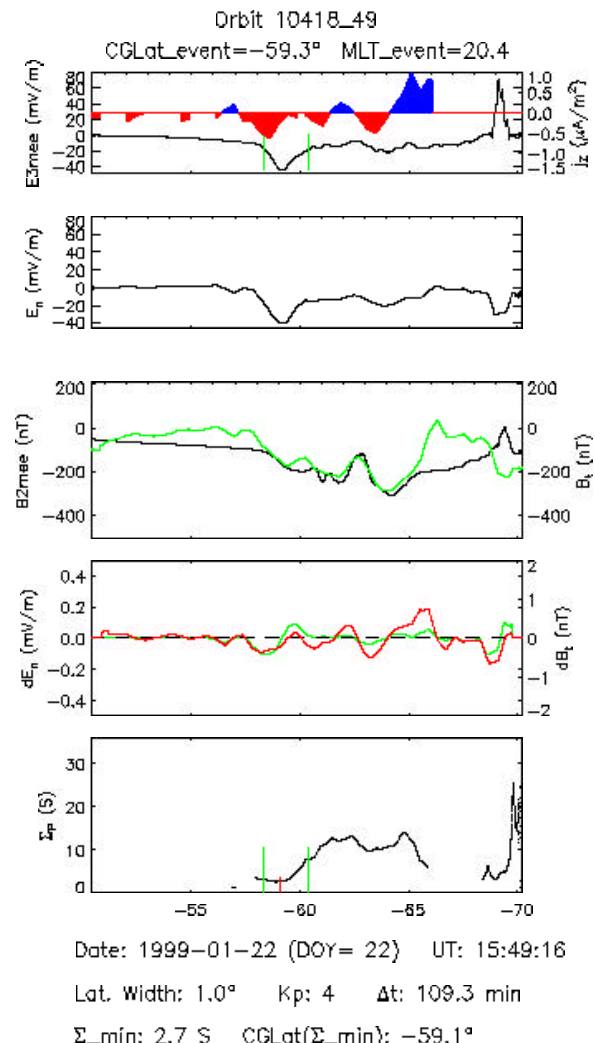
Fig. 6. Results obtained for the Southern Hemisphere satellite or- bit passage on 22 January 1999. First panel: the solid line rep- resents the measured electric field poleward component ( E 3 mee ). The two green guidelines delimit the event region. With red (blue) color the regions of downward (upward) FAC are shown; Second panel: horizontal electric field component projected on the current sheet normal axis ( E n ); Third panel: the black line represents the eastward magnetic field component ( B 2 mee ) and the green line the horizontal magnetic field component projected on the current sheet tangential direction ( B t ); Fourth panel: E n (green line) and B t (red line) differentials along the satellite track; Fifth panel: calculated height-integrated Pedersen conductivity profile 6 p . The red guide- line indicates the conductivity minimum position associated with the SAID event. The event region is here again delimited by the two green